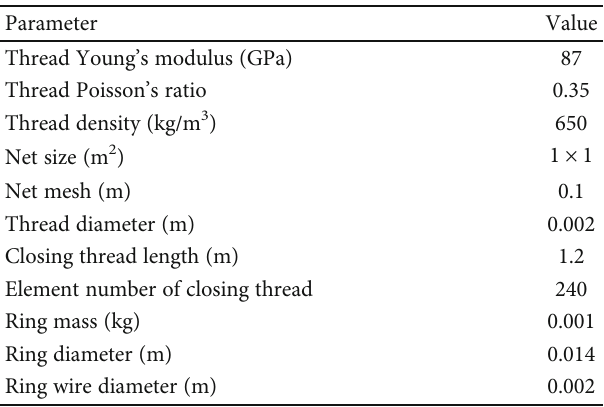
Figure 10: One-edge closure experiment and simulation. Table 2: Experimental and simulation